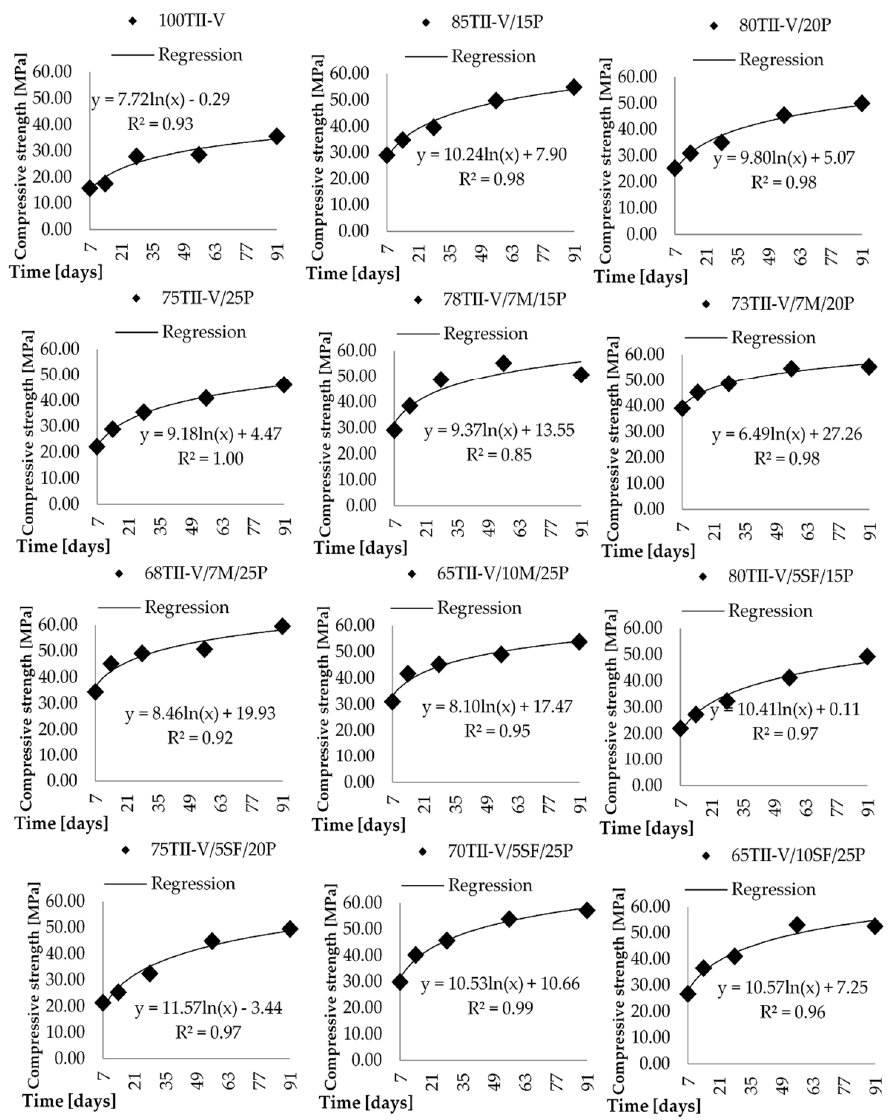
Figure 3. Correlation of strength versus concrete age for pumice, metakaolin, and silica fume-based mixtures.